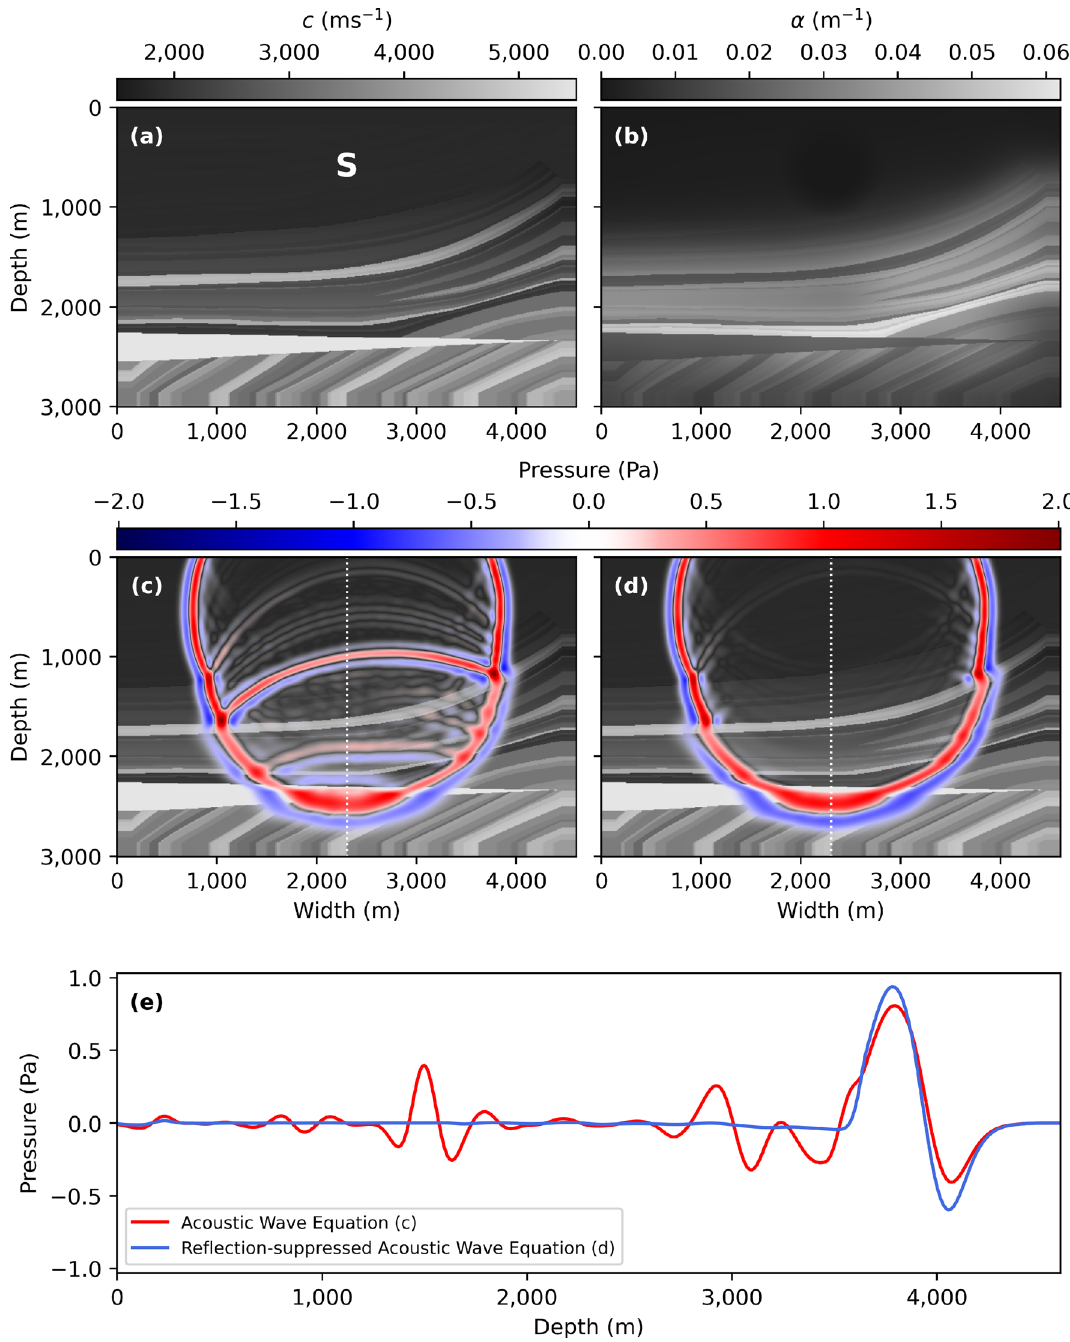
Figure 4. ( a ) The wave-speed of the Marmousi model with point source location S and ( b ) local suppression constant α( (cid:31) r ) . ( c ) shows a snapshot of the wave-field at t = 1.12 s for the acoustic wave equation (1, 2) and ( d ) the reflection-suppressed wave Eqs. (3, 4), using a peak frequency of 10 Hz, 10 grid-points per smallest wavelength, and a CFL 20 number of 0.5. The resulting space interval and step-size become (cid:31) x = 5.70 · 10 − 4 m and (cid:31) t = 5.18 · 10 − 4 s, respectively. ( e ) shows a cross-section through snapshots ( c ) and ( d ) along the white dotted-line. A video of all snapshots is available as supplementary